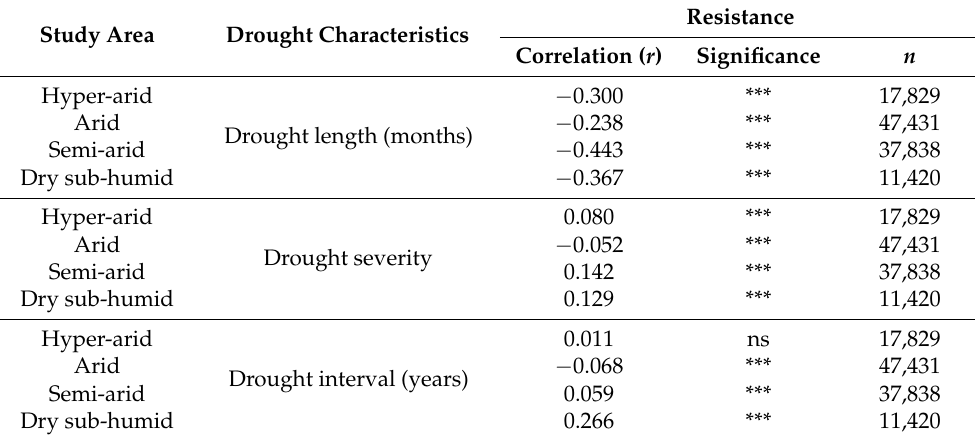
Table 1. Correlations between resistance and drought characteristics in hyper-arid, arid, semi-arid, and dry sub-humid regions.